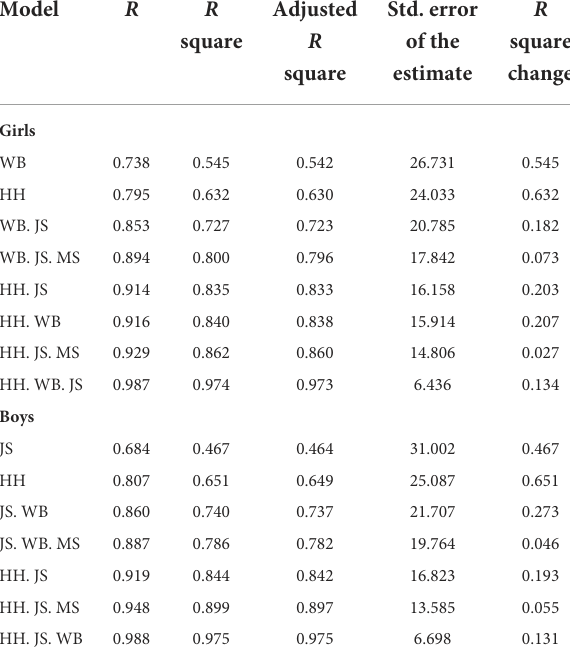
TABLE 4 Data from stepwise linear regression declared among 8-year TABLE 5 Data from stepwise linear regression declared among 9-year aged subject of both sexes. aged subject of both sexes. Model R R Adjusted Std. error R Model R R Adjusted Std. error R square R of the square square R of the square square estimate change square estimate change